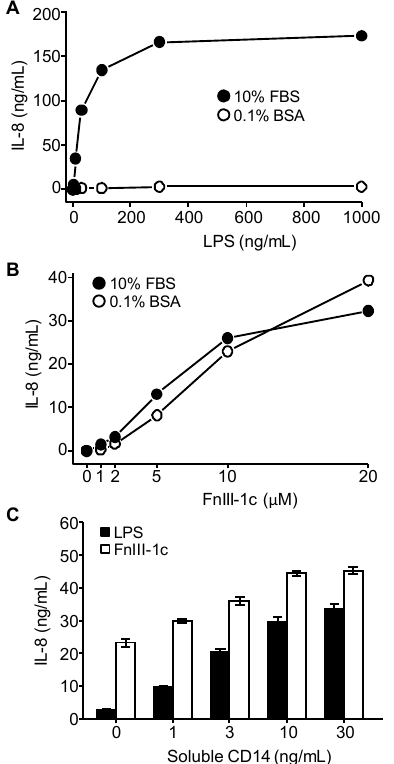
Figure 3 . Effect of serum and exogenous CD14 on LPS and FnIII-1c-induced IL-8 expression in dermal fibroblasts. Monolayers of human dermal fibroblasts were incubated for 24 hours with the designated concentrations of ( A ) LPS or ( B ) FnIII-1c in either 10% FBS/DMEM or 0.1% BSA/DMEM. ( C ) Cells were treated for 24 hours with LPS (250 ng/mL) or FnIII-1c (10 µM) in the presence of increasing concentrations of exogenous soluble CD14 in 0.1% BSA/DMEM. IL-8 concentration in conditioned medium was measured by ELISA. The data represent the mean ± S.E. of triplicate assays from three separate